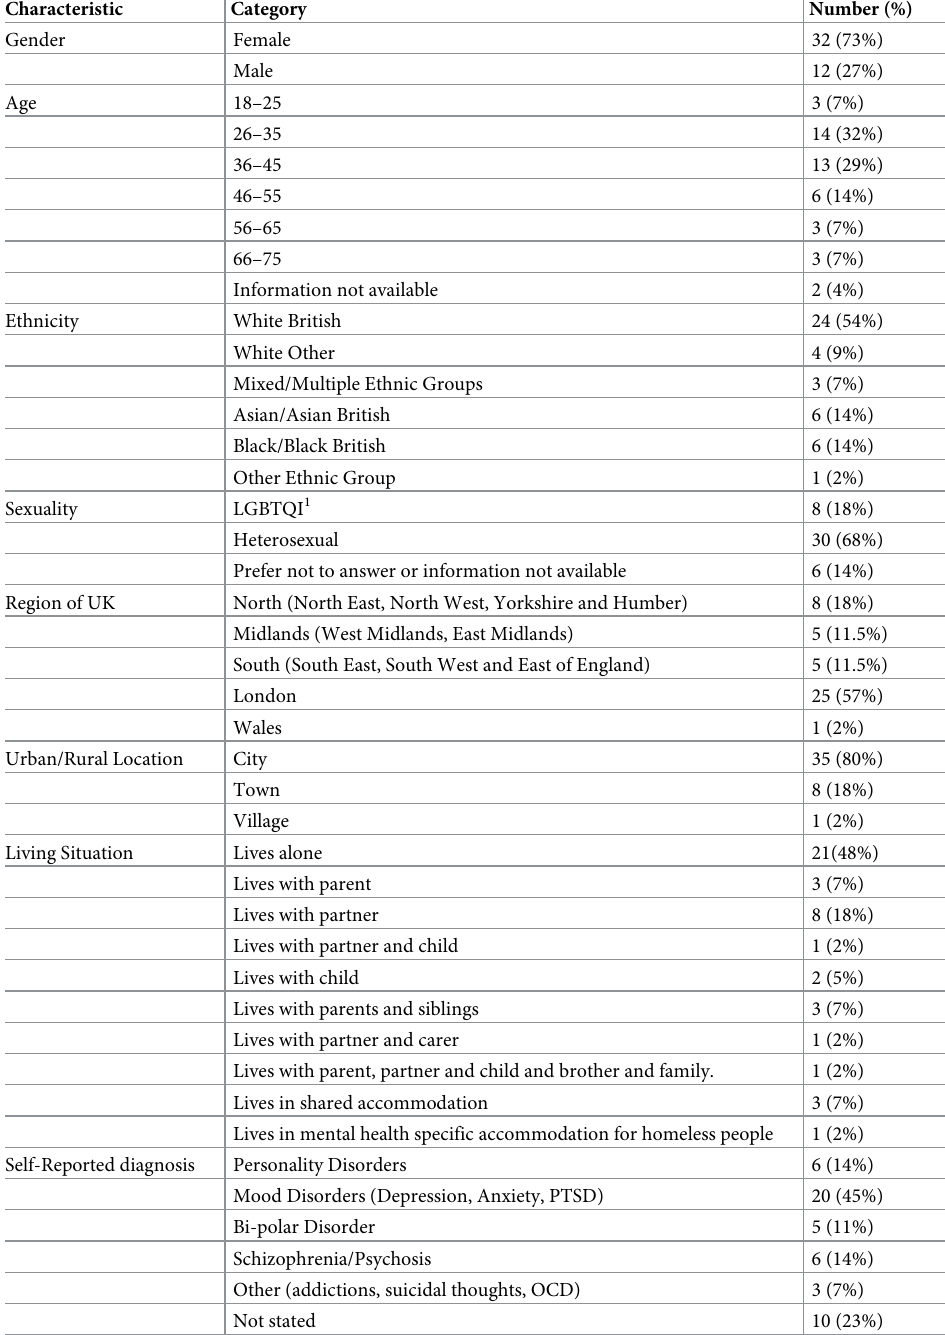
Table 1. Characteristics of participants (n =